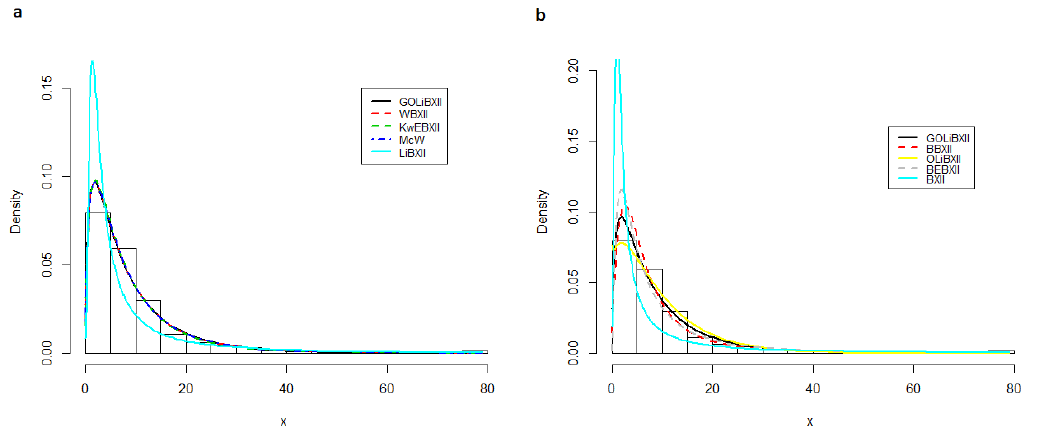
Figure 6 - The estimated GOLiBXII pdf and other estimated pdfs for cancer data. ( a ) The estimated GOLiBXII, WBXII, KwEBXII, McW and LiBXII densities. ( b ) The estimated GOLiBXII, BBXII, OLiBXII, BEBXII and BXII densities.